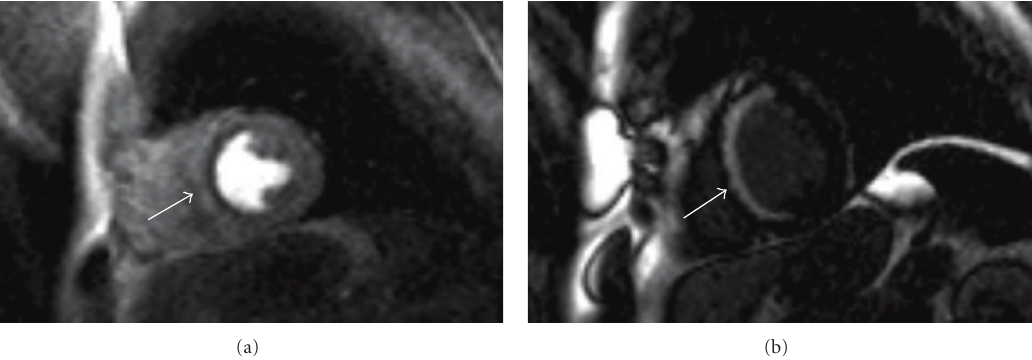
Figure 2: CMR in a patient with ischaemic cardiomyopathy. The cine imaging had shown normal wall thickness throughout but septal akinesis. (a) First pass perfusion sequence following administration of vasodilator stress with adenosine. A defect is seen throughout the septum. (b) Almost full thickness LGE is seen in the septum highly suggestive that this area is